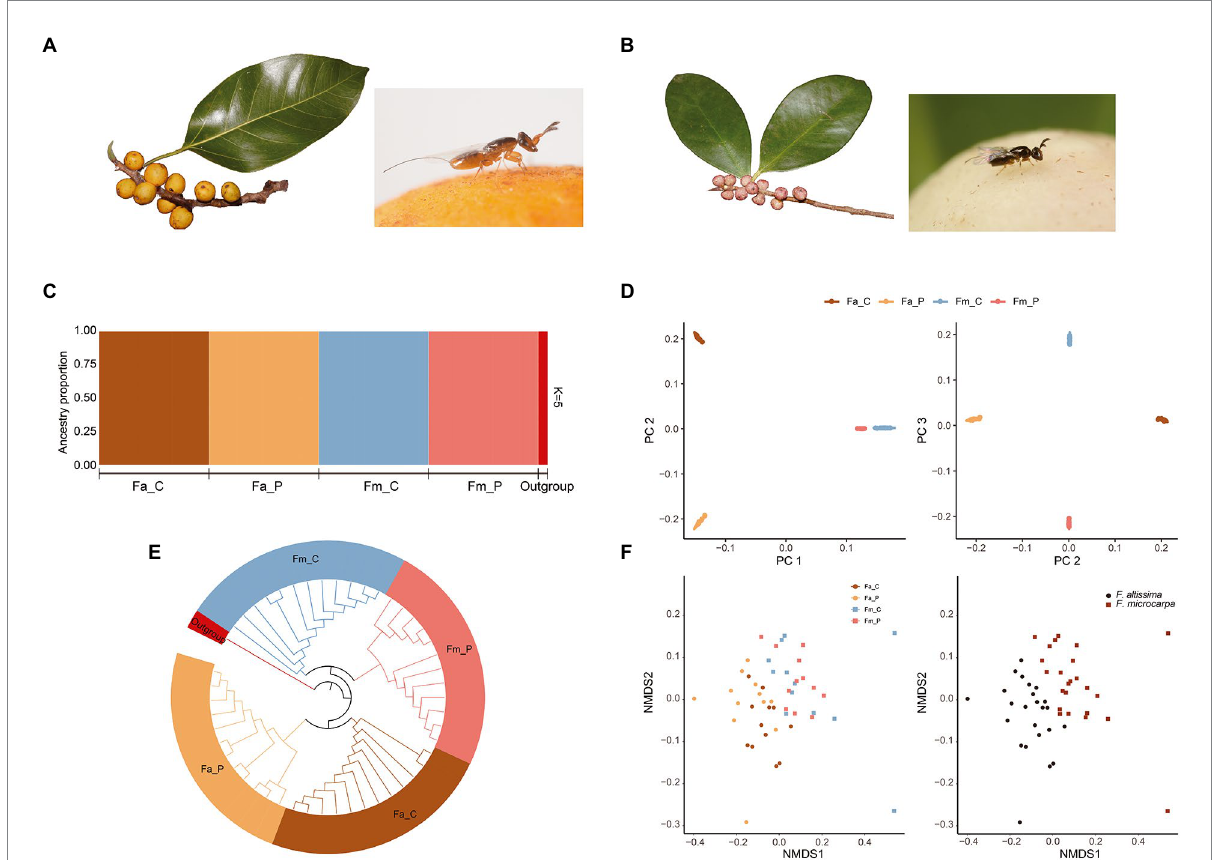
FIGURE 1 Phylogenetic, population genetic, and microbial similarity analysis of four fig wasp species. (A) Ficus altissima and its associated fig wasp; (B) F. microcarpa and its associated fig wasp. (C) Faststructure plot depicting ancestry proportions of each species in K = 5. (D) Genetic clusters identified based on the PC1 and PC2, PC2 and PC3 from the smartPCA analysis. (E) NJ tree constructed using the SNPhylo, the colors represented each species. (F) The Non-metric multidimensional scaling (NMDS) ordination analysis based on the composition of microbial communities. (Left) the Non-metric multidimensional scaling ordination (stress = 0.15, p < 0.01) produced with the Bray–Curtis dissimilarity distance metric. (Right) the same results of Left represent from different host figs. Fa_C represents the cheater of F. altissima ; Fa_P represents the pollinator of F. altissima ; Fm_C represents the cheater of F. microcarpa ; Fm_P represents the pollinator of F. microcarpa